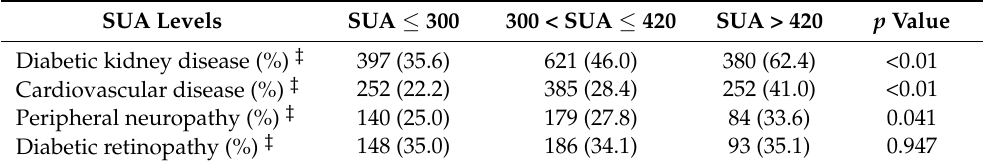
Table 2. The number (percentage) of patients with different chronic complications of diabetes across different serum uric acid levels.